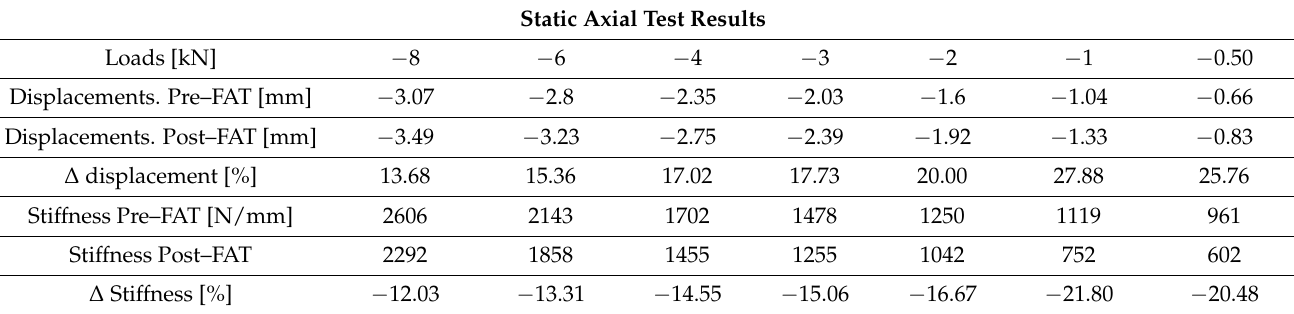
Static Axial Test